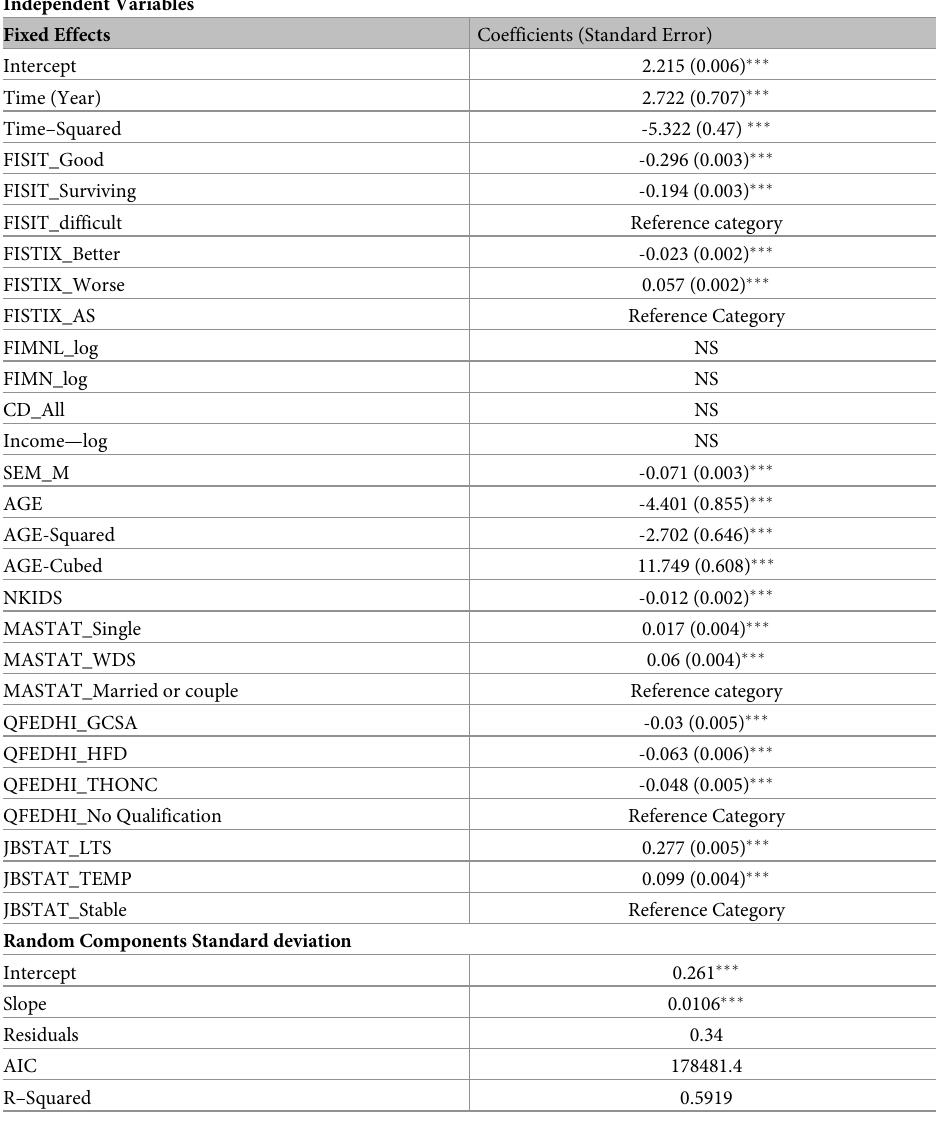
Table 4. Model parameter estimates